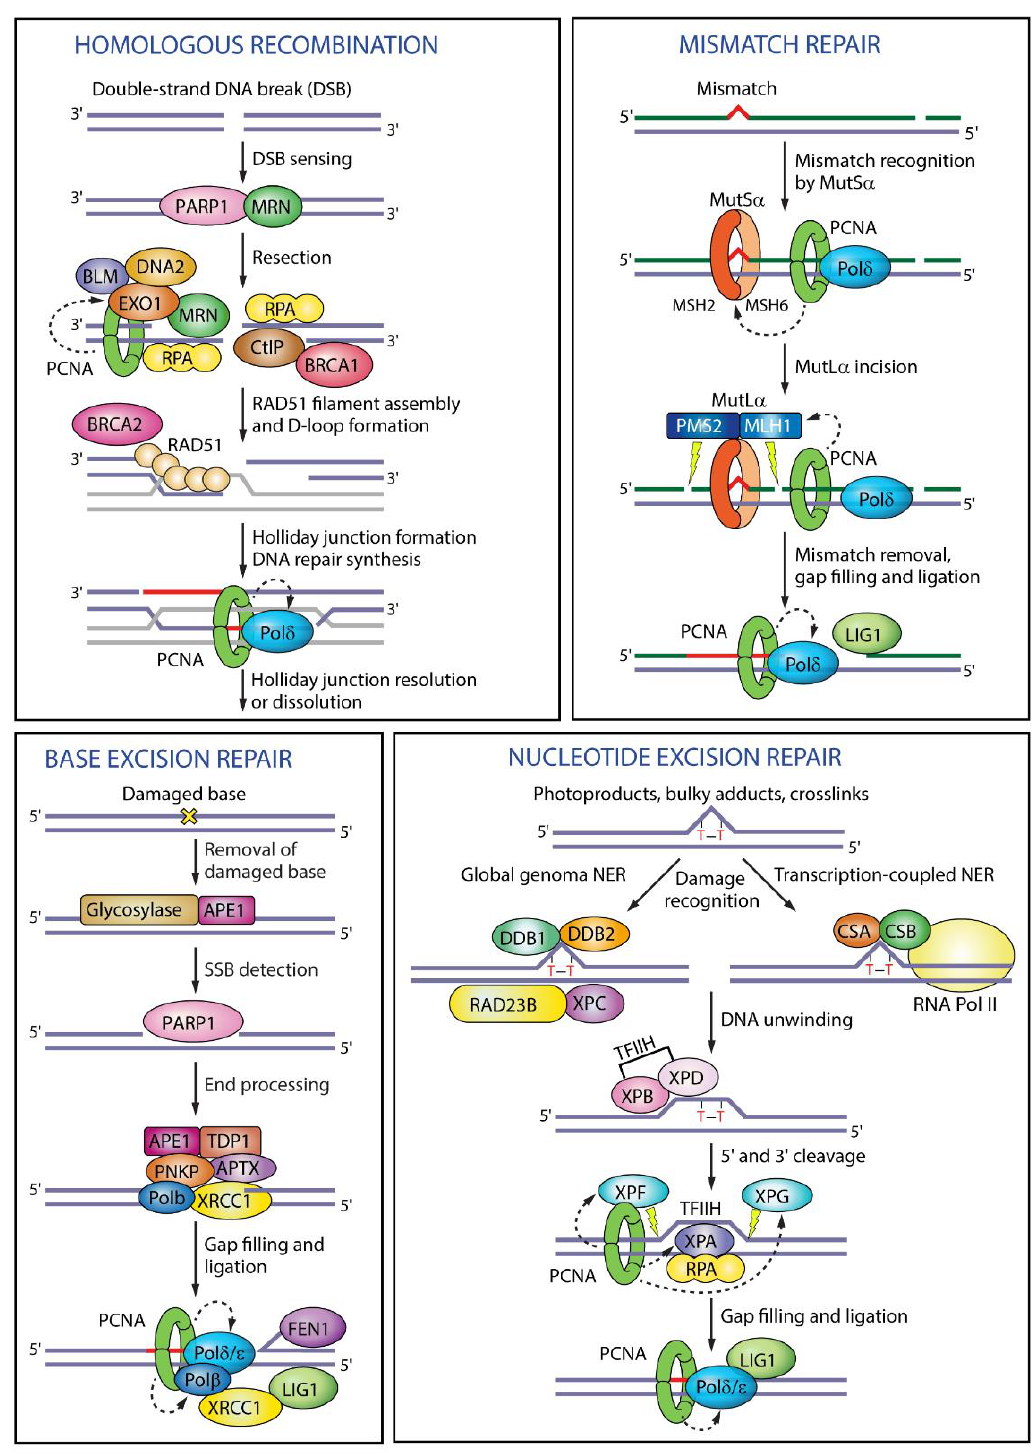
Figure 5. Overview of PCNA in DNA repair mechanisms. Reprinted from ref [66] under the terms and conditions of the Creative Commons Attribution (CC BY) license (full terms at http: //creativecommons.org/licenses/by/4.0/ (accessed on 3 November